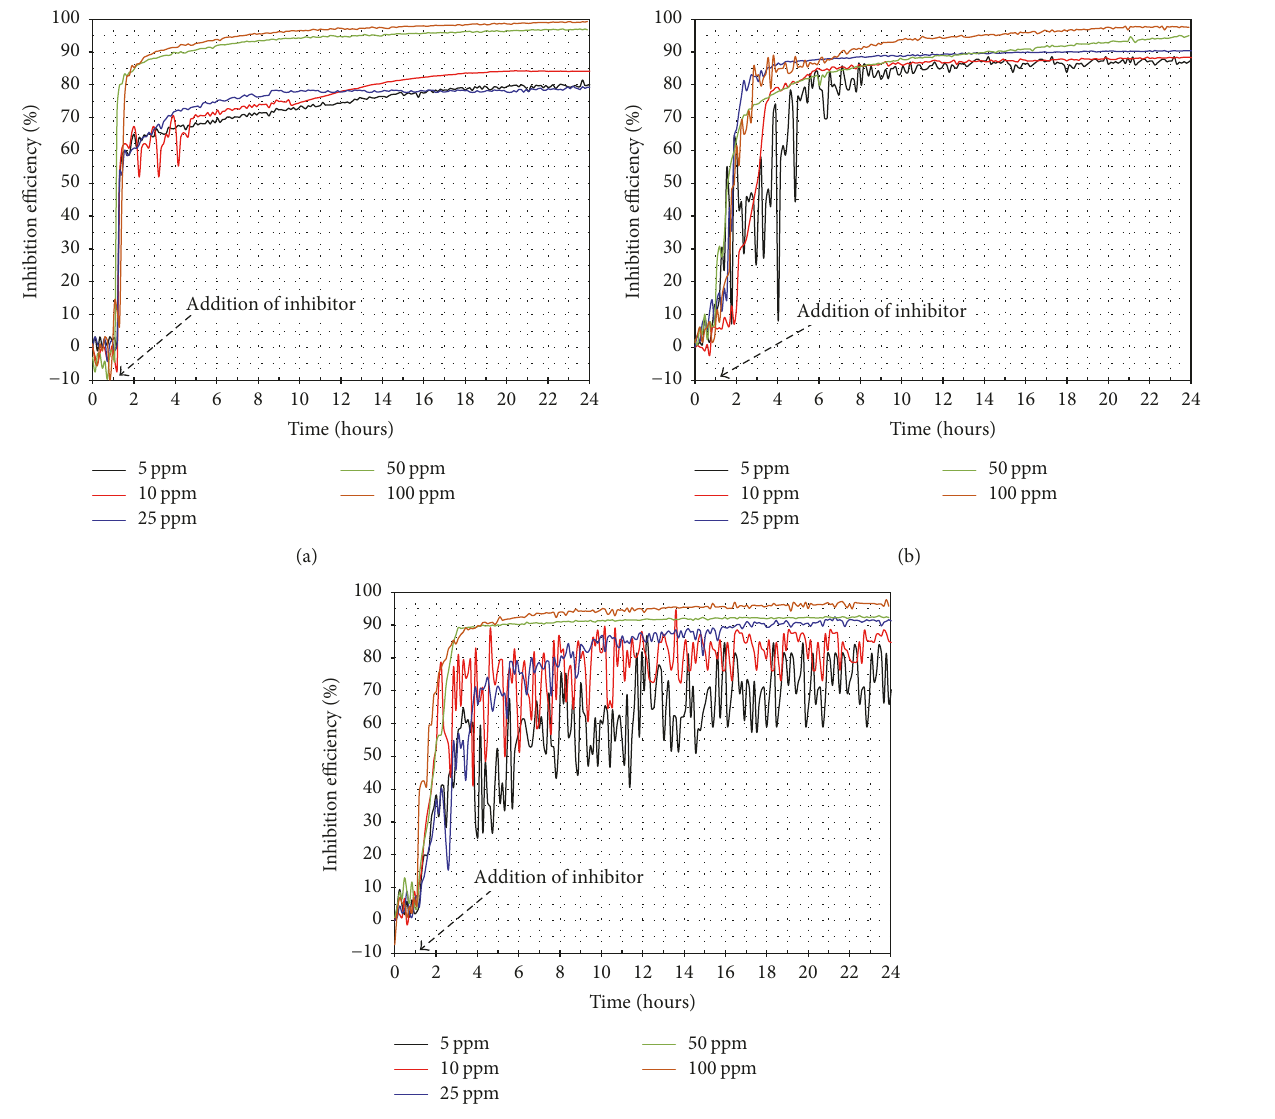
Figure 5: Variation of inhibition efficiency determined from HDA-based measurements (real-time monitoring): (a) 30 ∘ C, (b) 50 ∘ C, and (c) 70 ∘